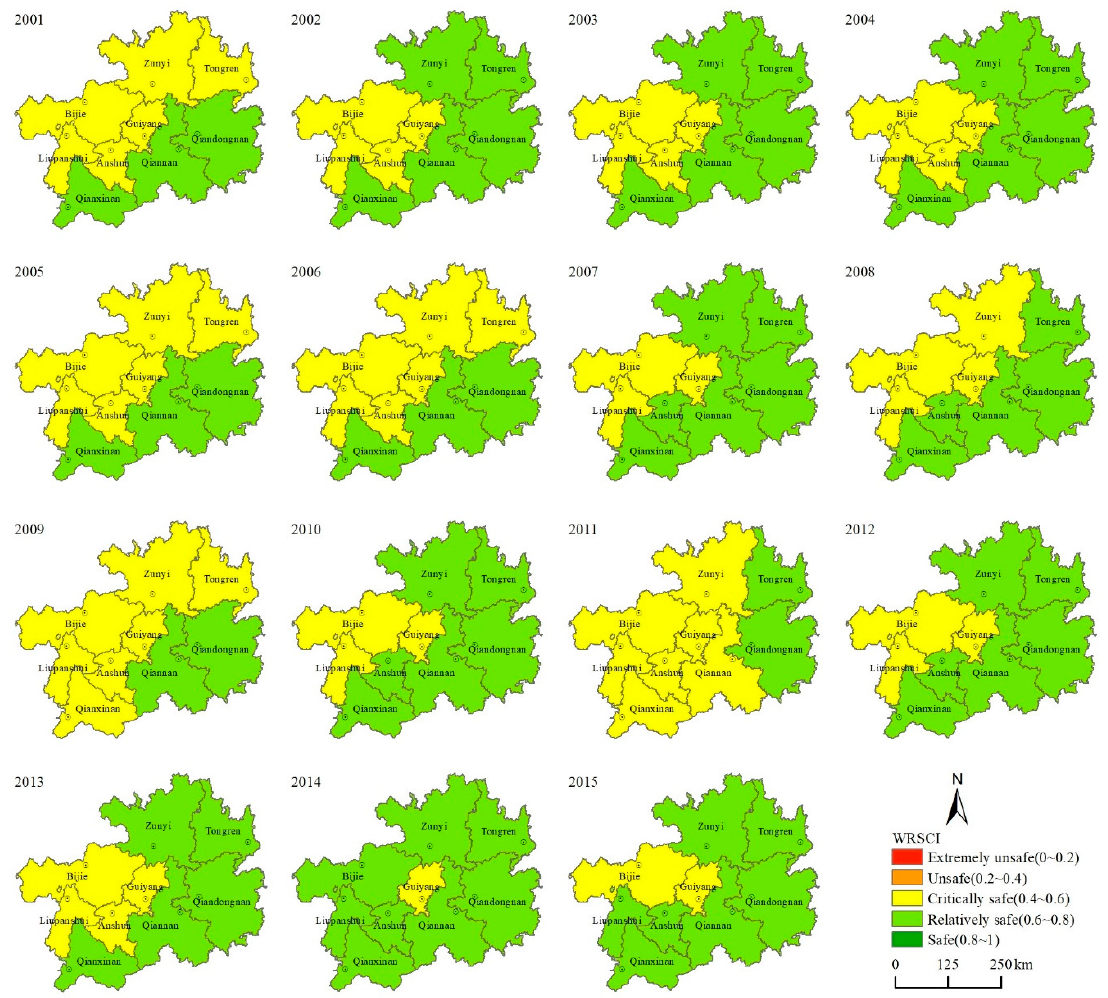
Figure 6. Spatiotemporal patterns of the WRSCI (Water Resources Security Comprehensive Index) in various cities and states in Guizhou Province in 2001–2015.